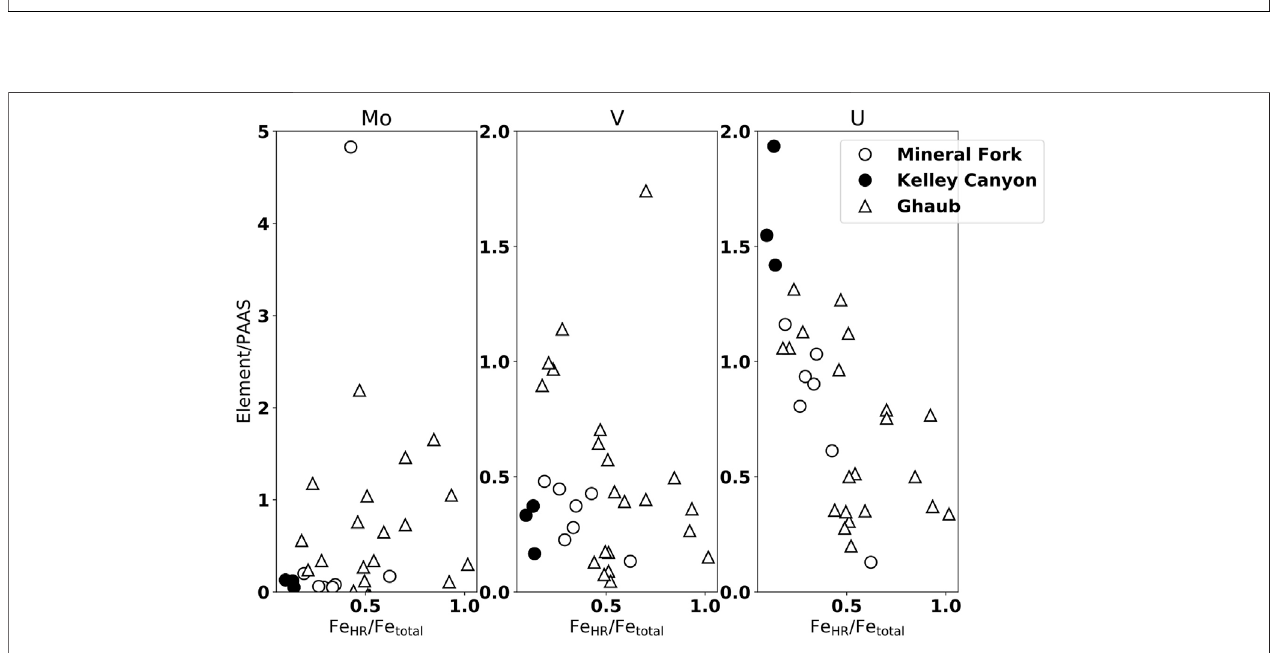
FIGURE 5 | Trace element concentrations normalized to Post-Archean Average Shale (PAAS), plotted against iron speciation data from the Mineral Fork (open circles),KelleyCanyon(closedcircles),andtheGhaubFormation(triangles).Ingeneral,theGhaubFormationhashigherenrichmentsinallredoxsensitivetraceelements, but values above oneindicate oxic weathering ofcontinentalcrust (e.g., Algeo and Tribovillard, 2009;Johnson et al.,2017b).Uraniumis enriched relativetoPAASin the samples from Utah, while V and Mo are not.